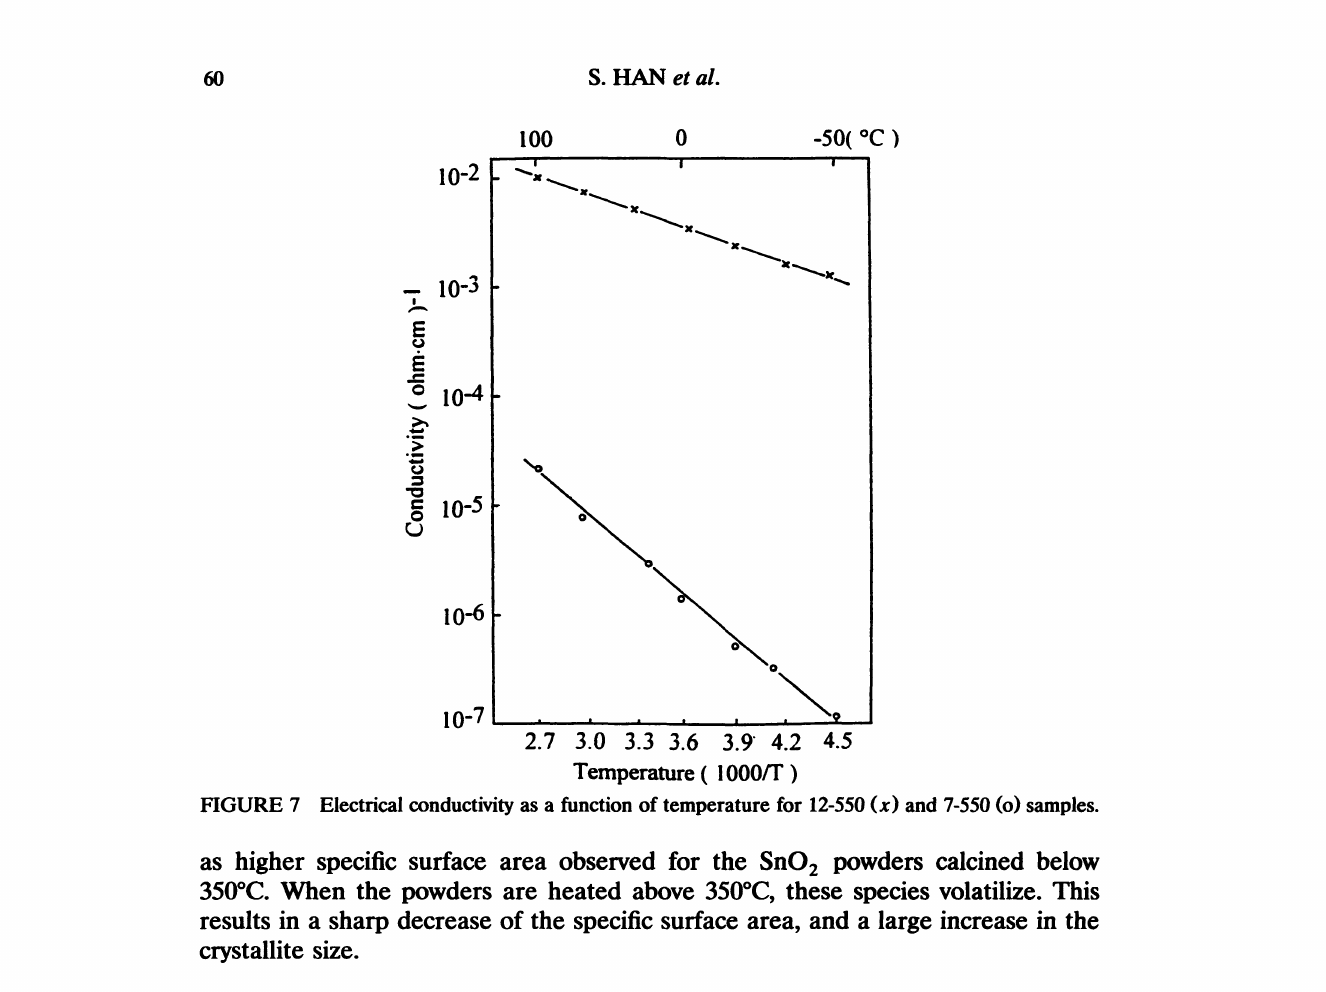
FIGURE 7 Electrical conductivity as a function of temperature for 12-550 (x) and 7-550 (o)